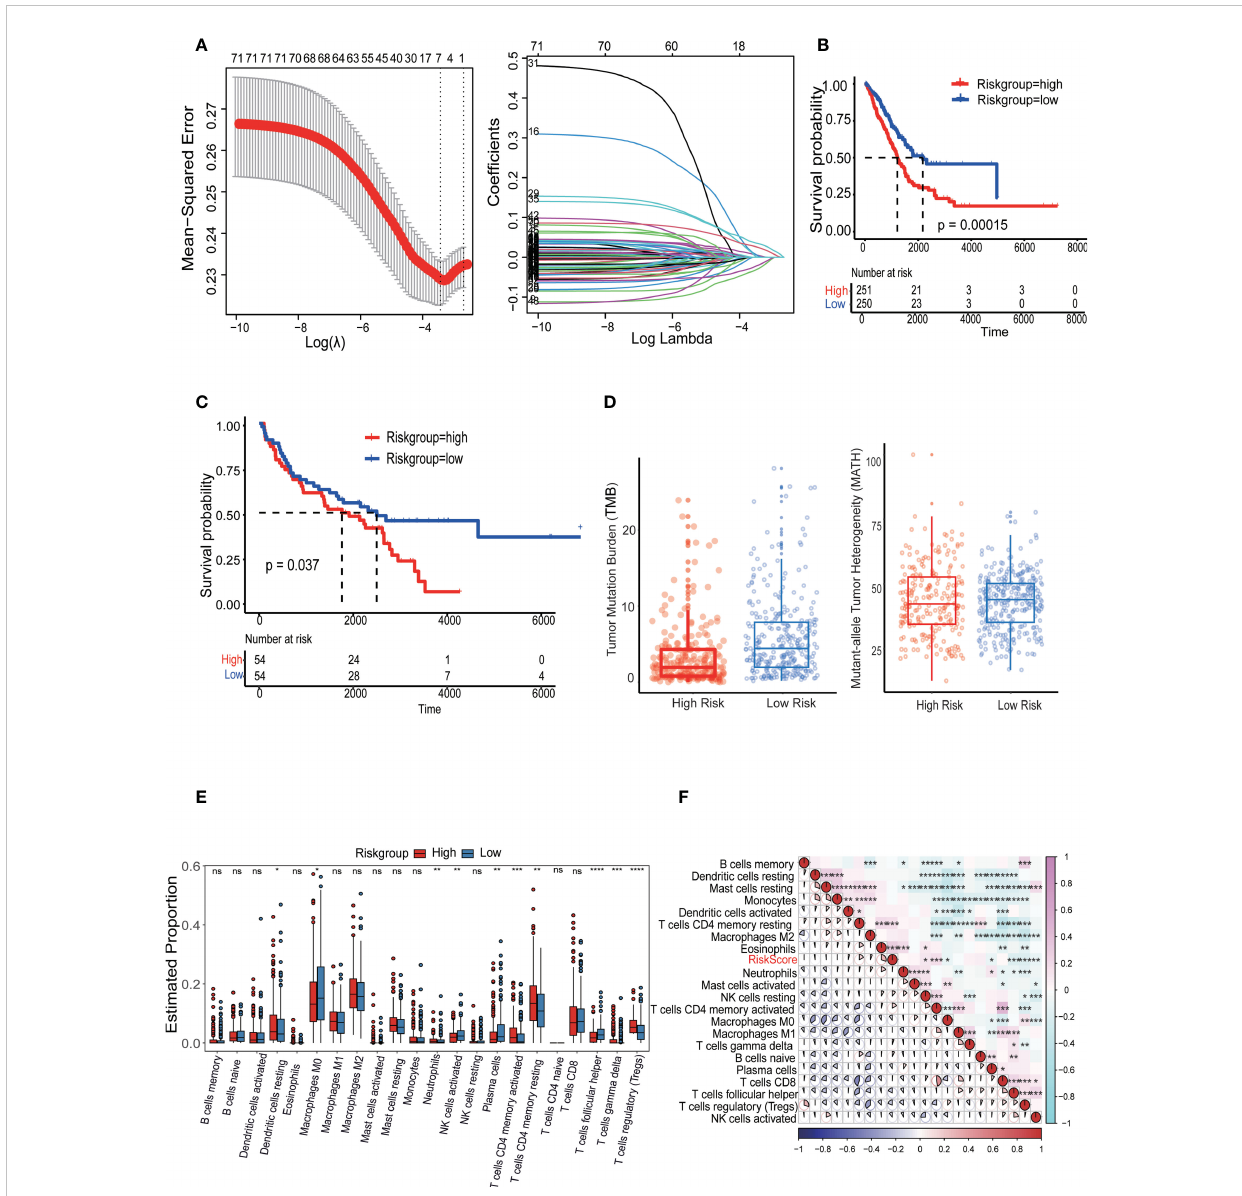
FIGURE 7 Identi fi cation and validation of the LRI-based classi fi cation of LUAD patients. (A) Construction of the cellular senescence score (CSS) and the impact of CSS on the clinical outcome of LUAD patients. A 336 cellular senescence cluster-related differentially expressed genes (DEGs) among the three cellular senescence clusters are shown in the Venn diagram. (B, C) Kaplan – Meier curves of L-R scores for patients in the high and low groups in the TCGA-LUAD cohort. (D) The tumor mutation burden (TMB) score and mutant-allele tumor heterogeneity (MATH) in the different subgroups of LUAD. (E) Analysis of the immune cell scores between the different L-R score groups using the CIBERSORT algorithm. (F) Correlation between the L-R score and immune cell score. ns p ≥ 0.05; *p< 0.05; **p<0.01; ***p<0.001;